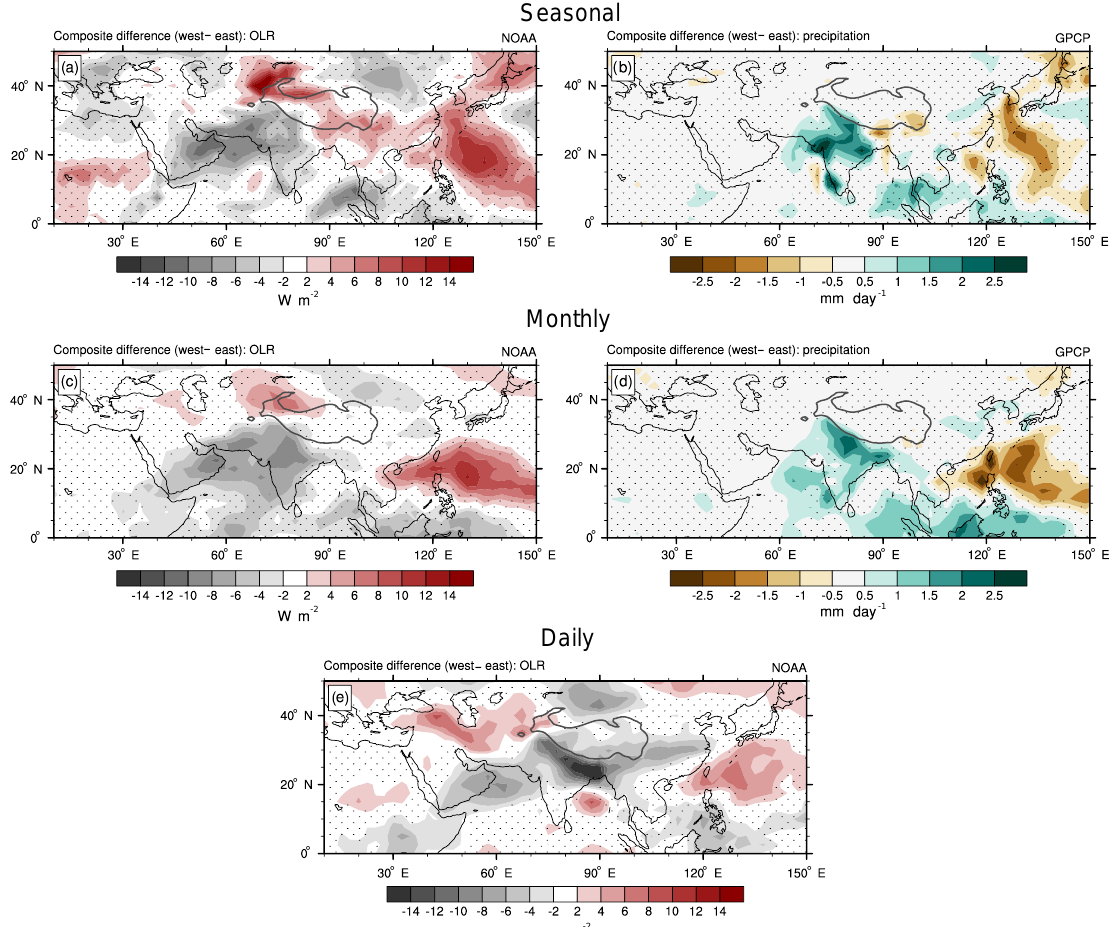
Figure 15. Composite differences of west minus east location of the SAH centre in the period 1979–2013 as diagnosed by ERA-I for (a, c, e) OLR (from NOAA in Wm − 2 ) and (b, d) precipitation (from GPCP in mmday − 1 ) based on (a, b) seasonal, (c, d) monthly and (e) daily data. Stippling indicates insignificant areas (significance less than 10%). Black contours show the location of the TP (orography higher than